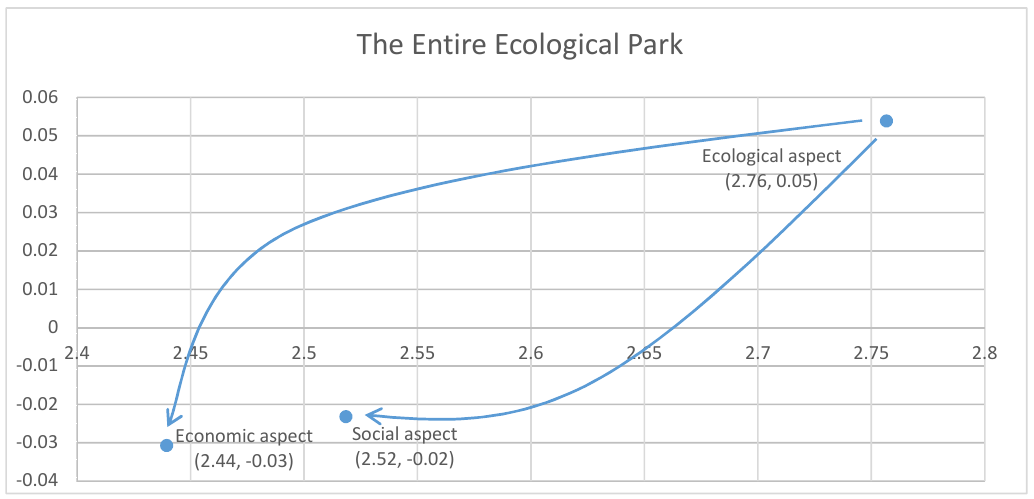
Table 2. DEMATEL results for the ecological park.